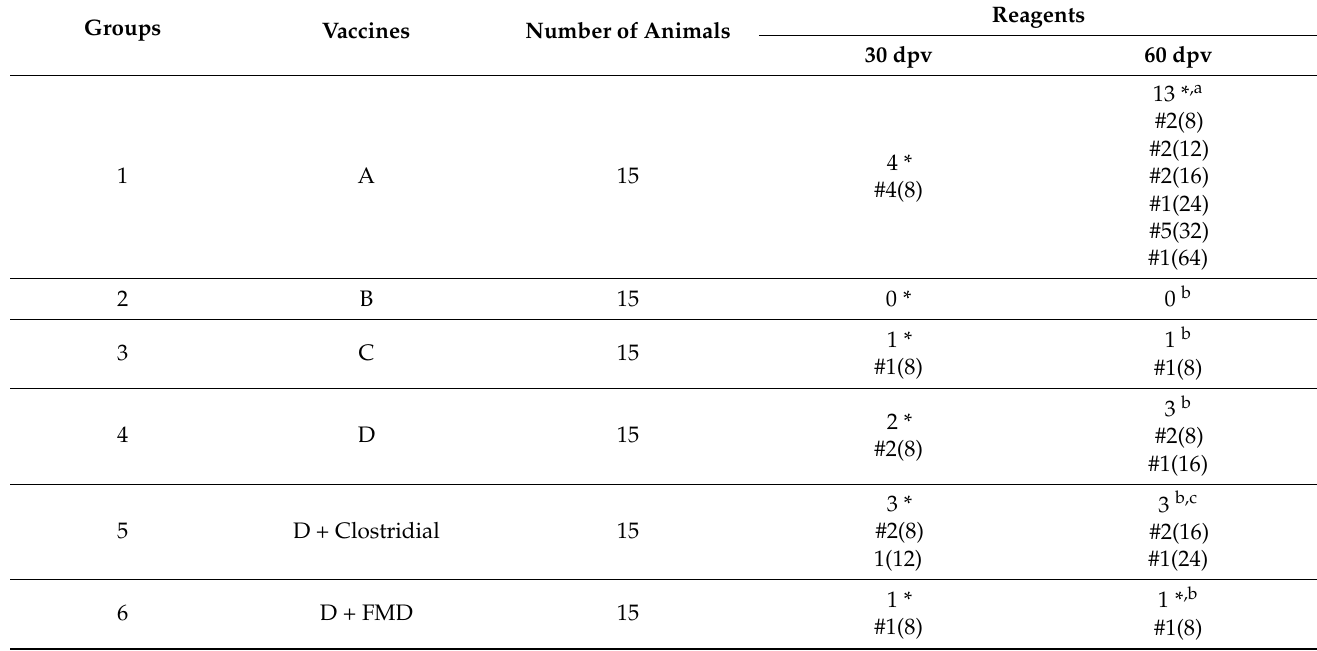
Table 2. Neutralization antibodies for BoHV-1 at 30 and 60 days post-vaccination (dpv) in cattle immunized with four commercial